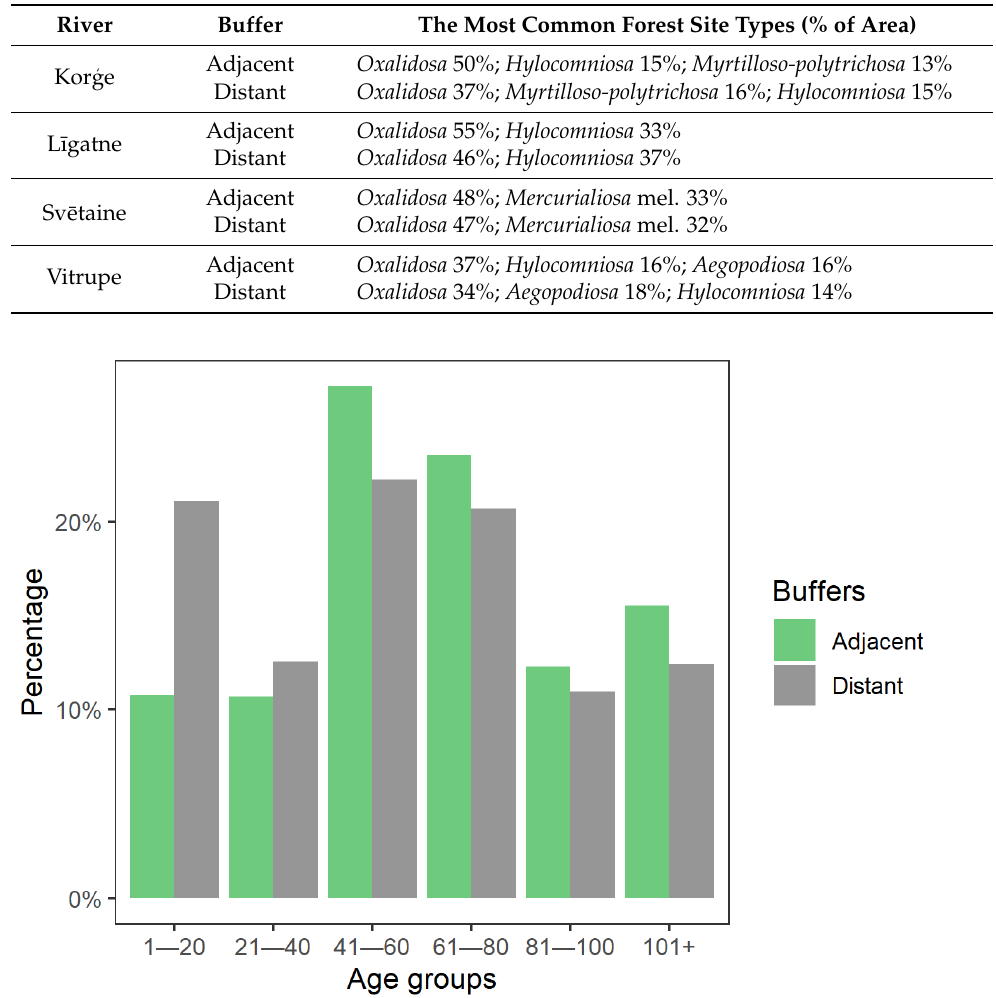
Figure 2. The division proportion (%) of stands by age group in adjacent (0–50 m) and distant (51–200 m) buffer strips in riparian forests.